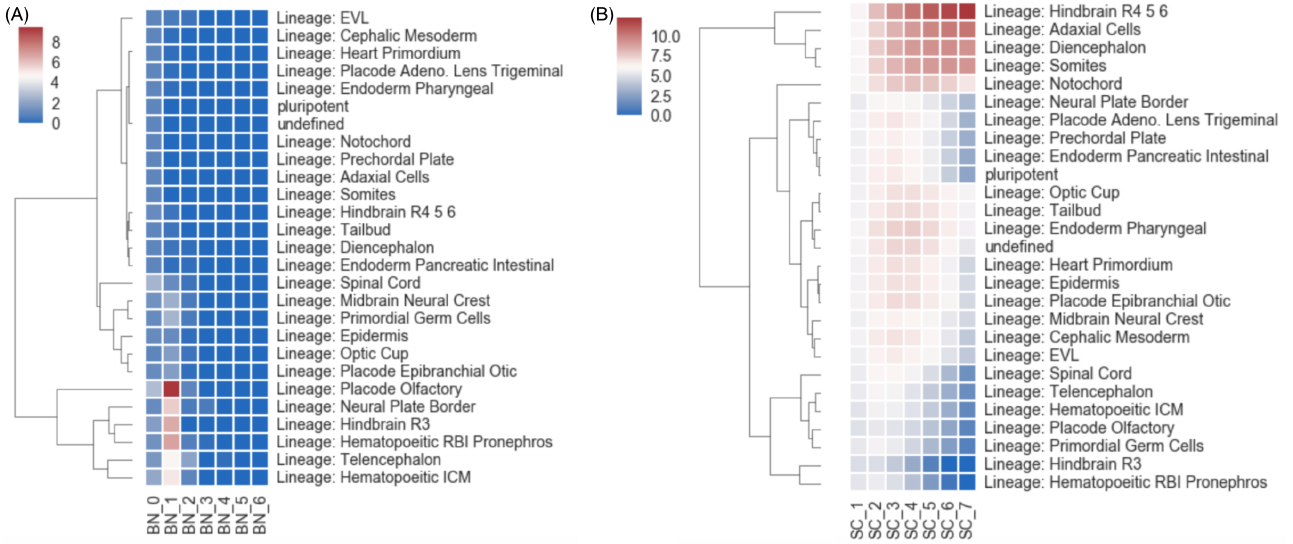
Figure 10. Cell lineage tracing with the simplicial statistics. In this analysis, hierarchical clustering was performed on the summary statistics of transcriptomic data of different cell types. ( A ) The heat map and clustering results when using the Betti numbers as the clustering features. ( B ) The heat map and clustering results when using the normalized simplicial complexity as the features for hierarchical